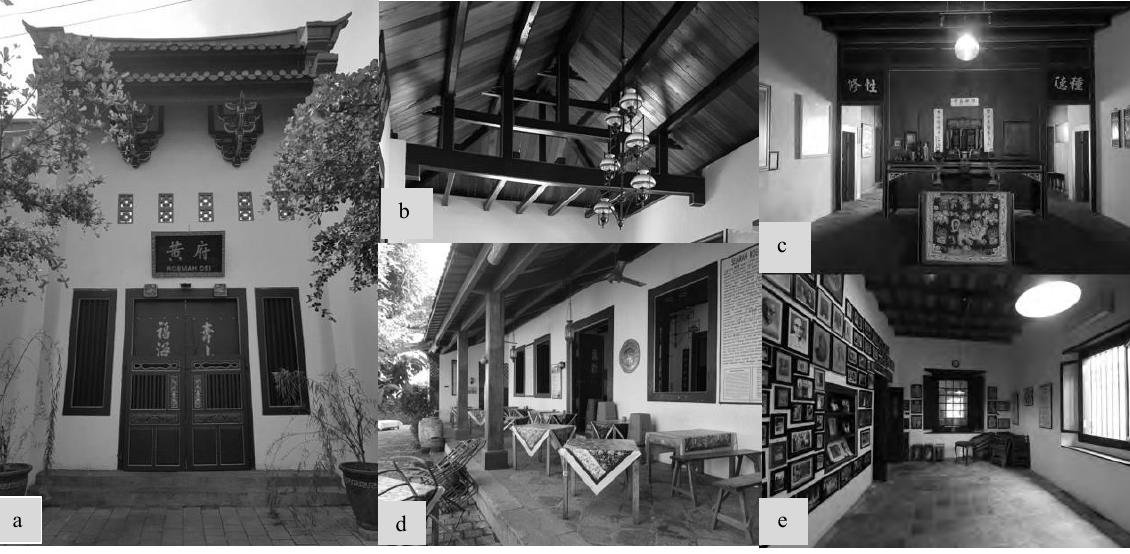
Figure 4. The original main building of the Oei House: (a) the main gate, (b) the exposed roof construction frame, (c) the main hall in the main building, (d) the front terrace functions as a café, and (e) the Oei family